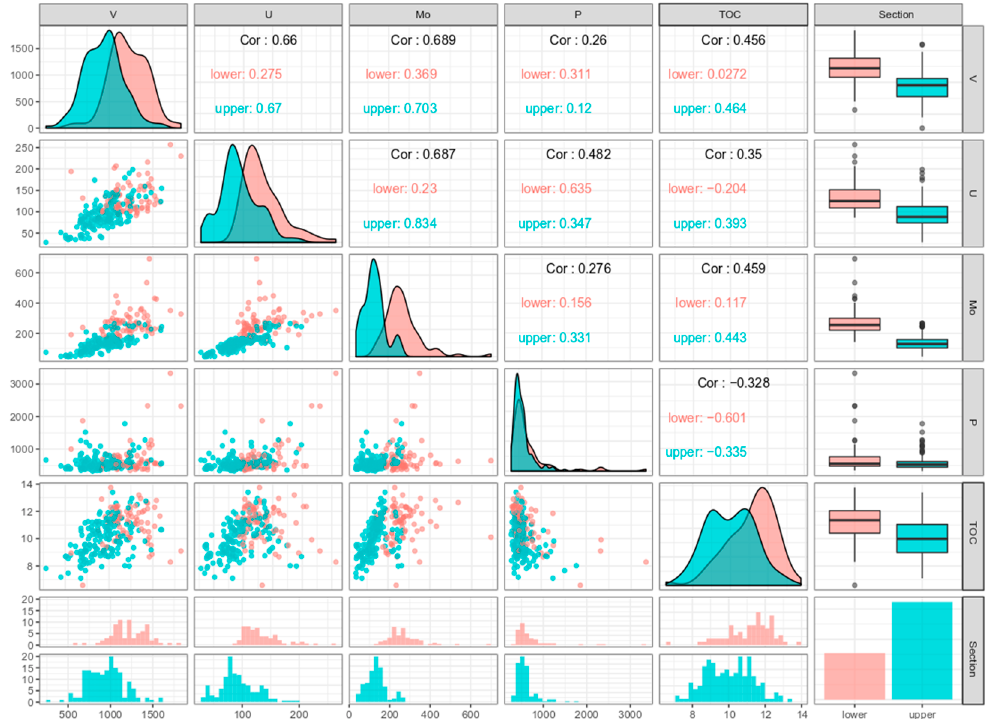
Figure 13. Associations of U in black shale with other redox-sensitive elements, P and total organic carbon (TOC). The division is made between the upper and lower bed. Based on core material originating from NW Estonia, no of observations 239 [38].